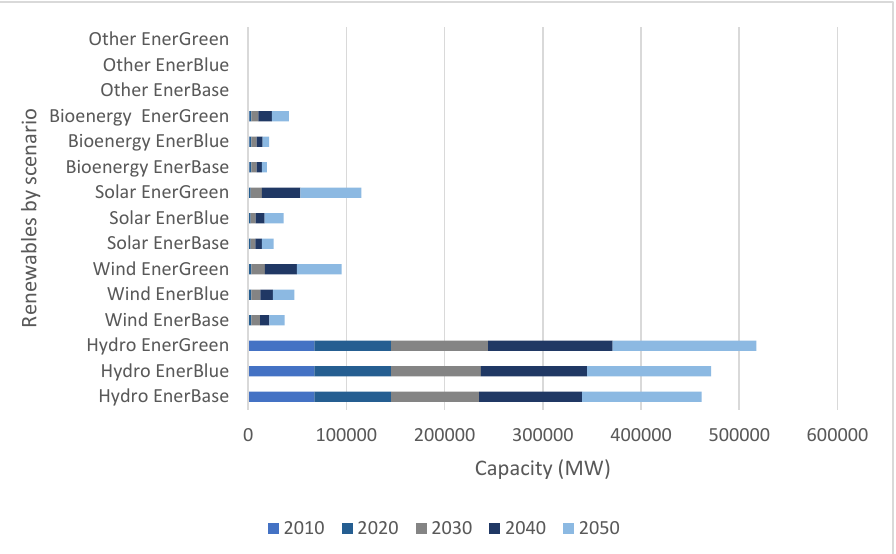
Figure 3. Renewable-based electric capacities in the CIS, by technology, MW. Notes: other sources include marine, geothermal, hydrogen fuel cells. Source: based on data from [30].